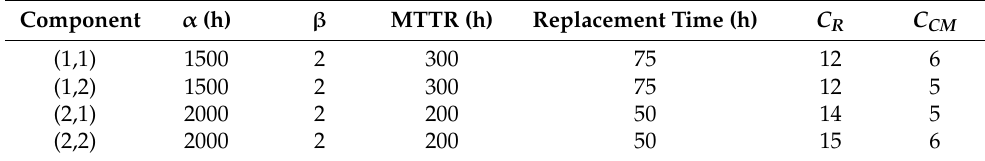
Table 2. System parameters and maintenance characteristics.